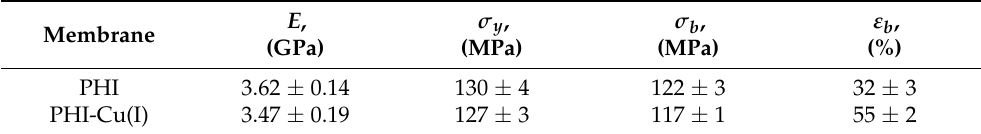
Figure 5. Stress–strain curves of (1) PHI and (2) PHI-Cu(I) membrane films. Figure 5. Stress – strain curves of (1) PHI and (2) PHI-Cu(I) membrane films. Table 1. Mechanical characteristics of the Table 1. Mechanical characteristics of the membranes.